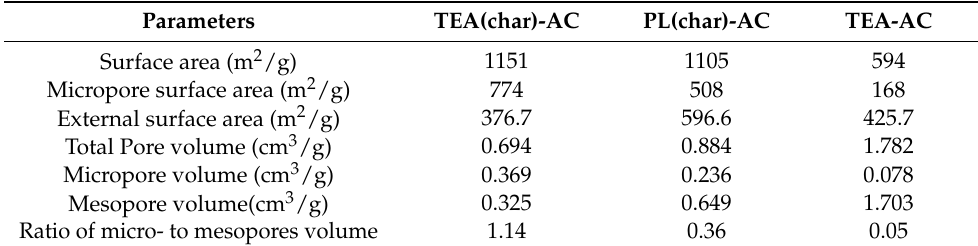
Table 1. Details of textural parameters of yielded ACs at activation temperature 650 ◦ C.